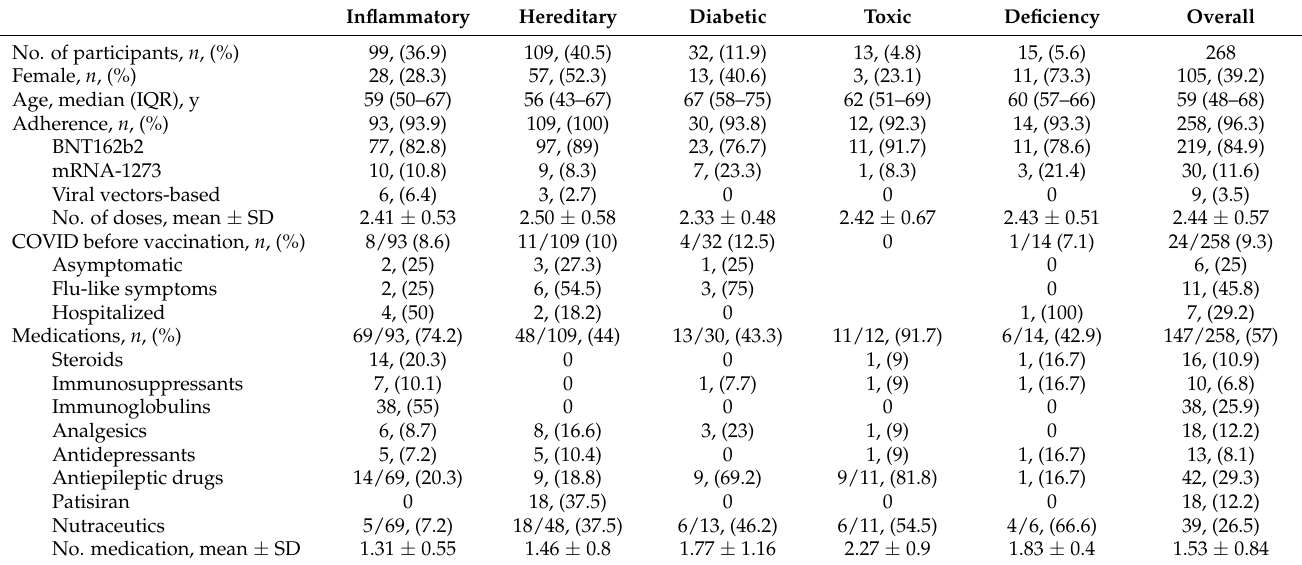
Table 1. Demographic and clinical features of the participants included in the final